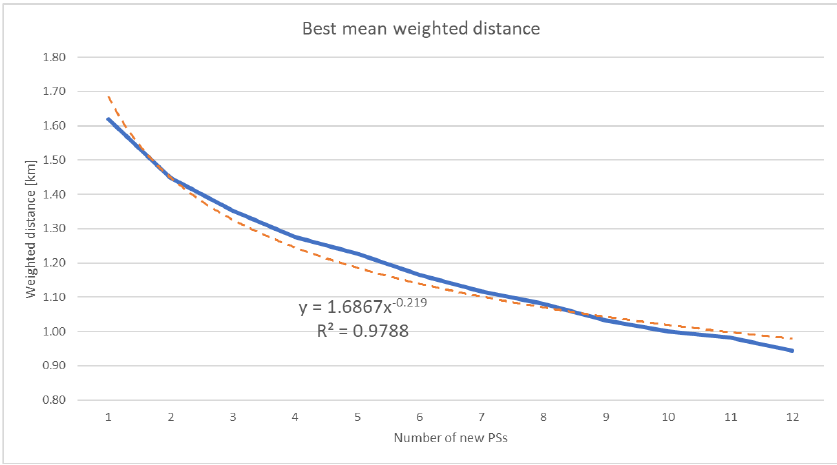
Figure 29. Trend of the best mean weighted distance in blue; regression curve in red.